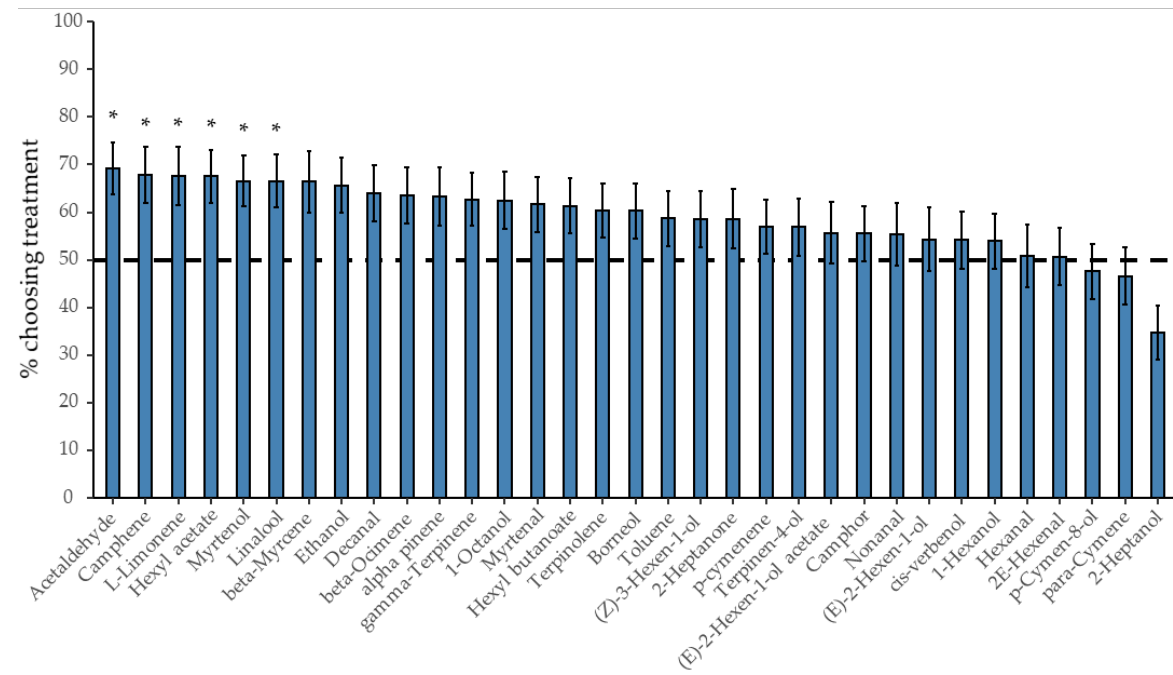
Figure 4. Results from two-choice preference tests of all the here identified and commercially available Rubus fruticosus volatiles. Column plot shows the attractivity (=the percentage of flies that chose the treatment vs. the control side) of each individual compound to Drosophila. suzukii females. Attractivity was tested against a 50:50 distribution, shown as a horizontal dotted line (binomial GLMM, FDR corrected, mean ± SE, *: p < 0.05).